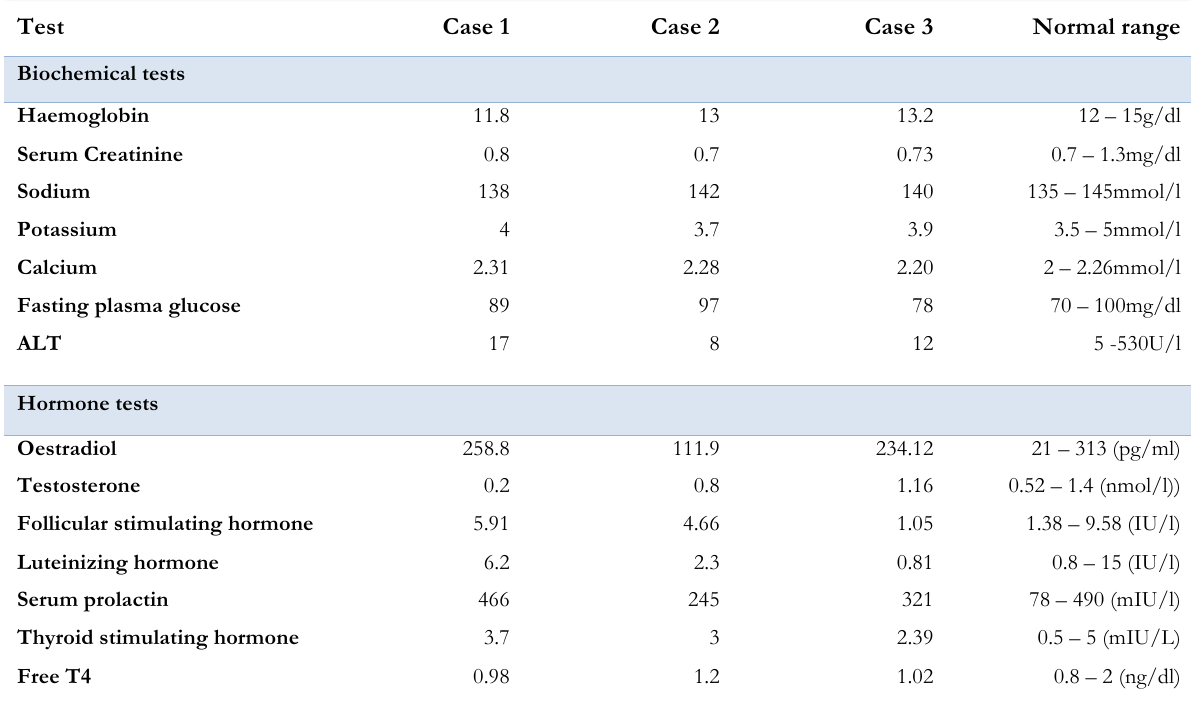
Table 1: Biochemical parameters of the patients